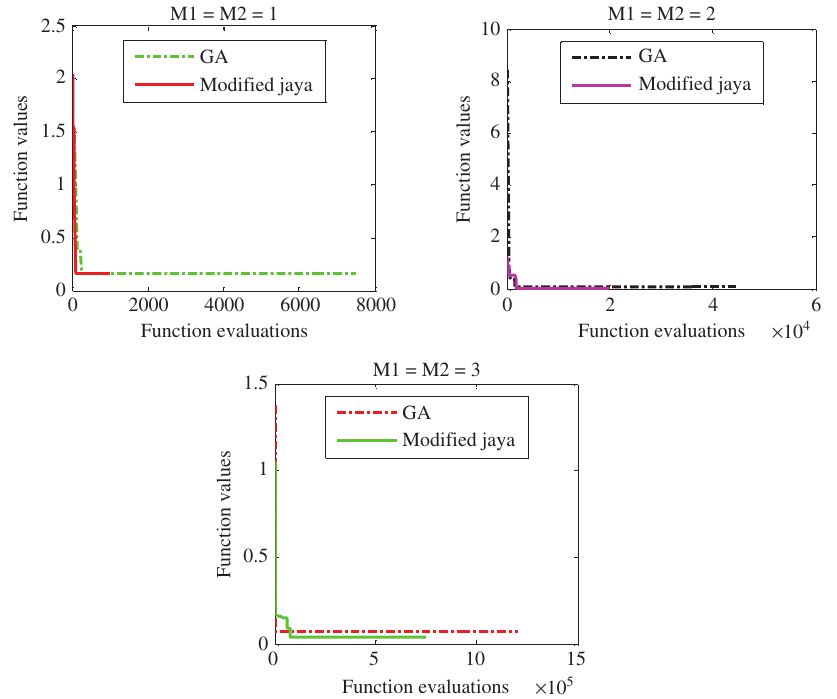
Figure 14: Convergence Rate of Best Objective Function Values in GA and Modified Jaya for the Number of Balance Masses for Case 2.